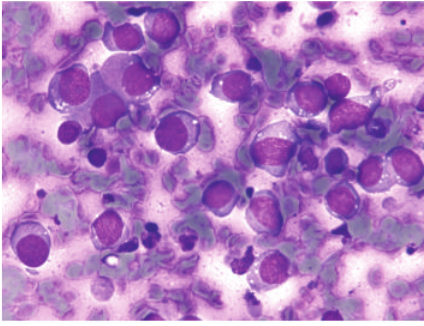
Figure 5: Hemacolor-stained smear showing cells bearing basophilic cytoplasm focally with several cytoplasmic fine vacuoles.